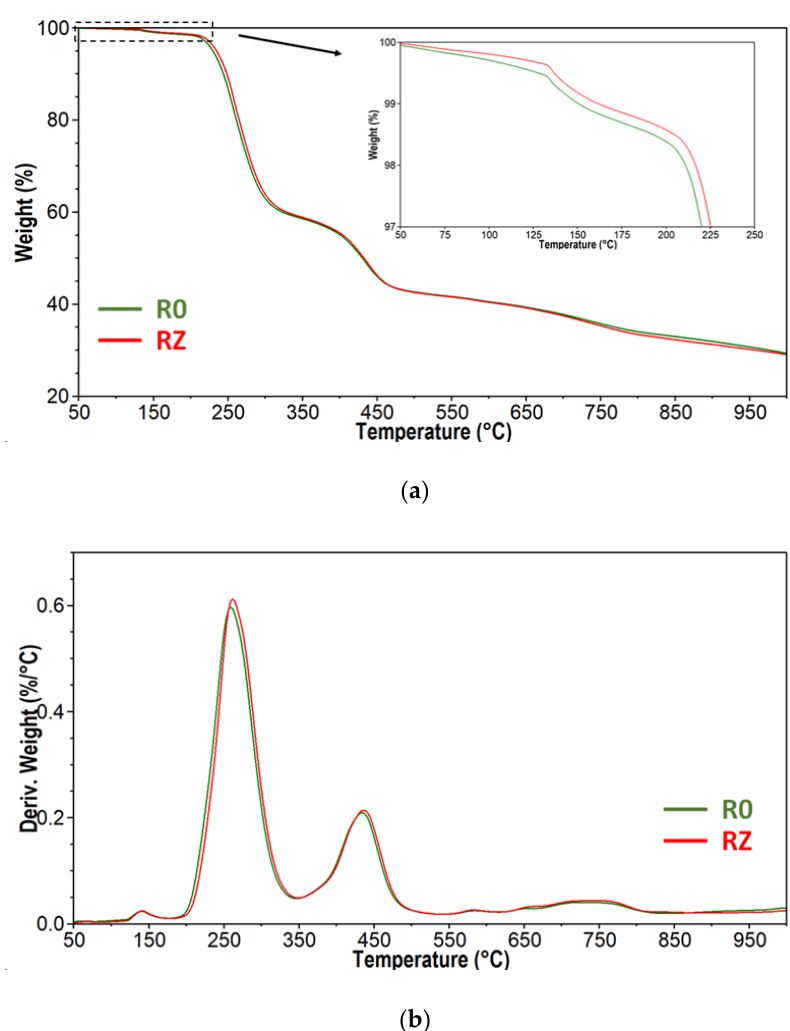
Figure 5. TGA ( a ) and DTGA ( b ) curves obtained for RO and RZ composite materials. Differences were observed for the softening temperature. A VST of 75 °C was obtained for RO profiles, while a VST of nearly 77 °C was obtained for RZ profiles. Both of these values are similar to the values obtained for façade profiles [47].